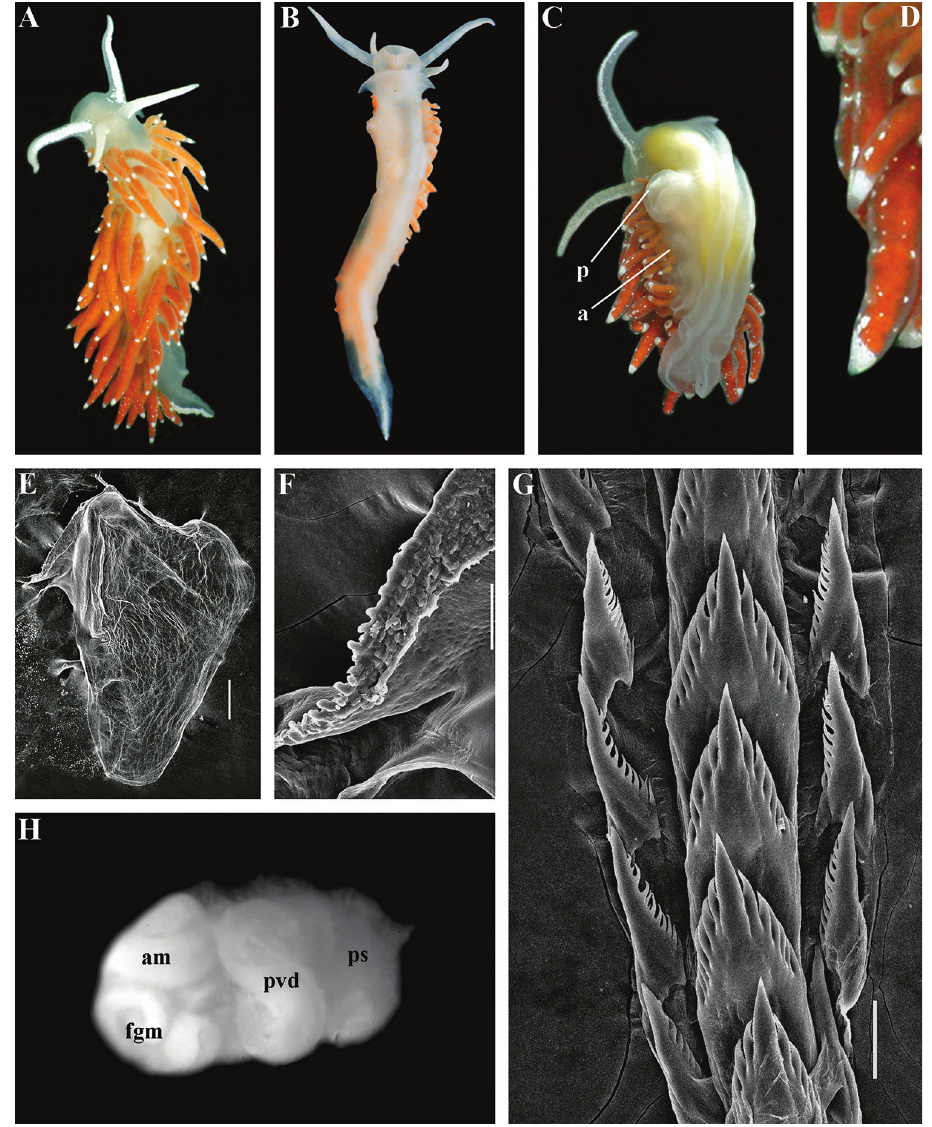
Figure 18. Coryphella pseudoverrucosa Martynov et al., 2015. ZMMU Op- 528. NW Pacific, Kamchatka, Avachinskaya guba, living specimen 12.5 mm in length (fixed): A dorsal view B ventral view C lateral view D details of cerata E jaw, SEM F details of masticatory process of jaw, SEM G radular teeth, posterior part, SEM H reproductive system, light microscopy. Abbreviations: a anus am ampulla fgm female gland mass p penis ps penial sheath pvd prostatic vas deferens. Scale bars: E = 300 μm; F 30 μm; G = 100 μm. Photos and SEM images by T.A. Korshunova, A.V.